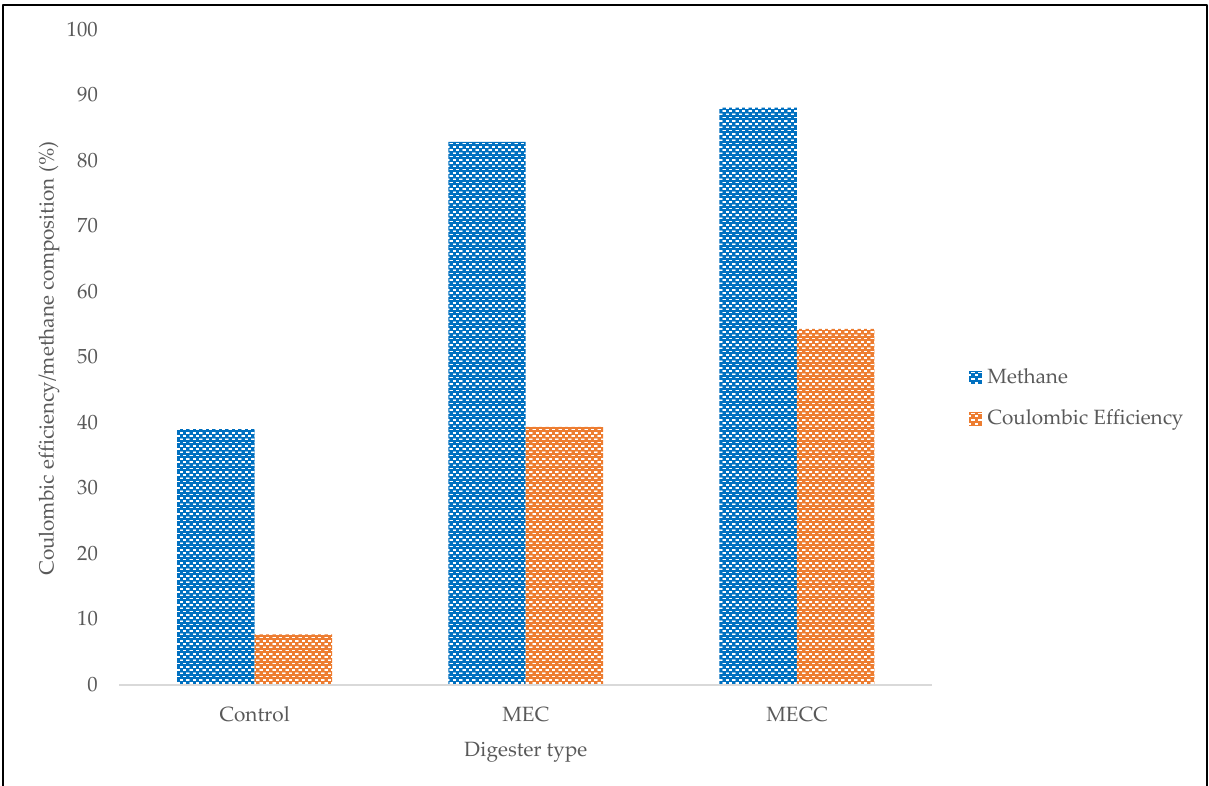
Figure 5. Coulombic efficiency and methane composition with respect to digester type.